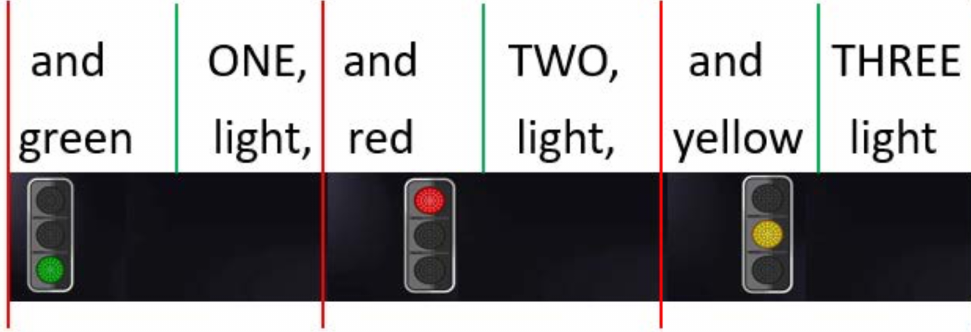
Figure 5. Audio-visual stimuli during the ball-drop-to-the-beat task